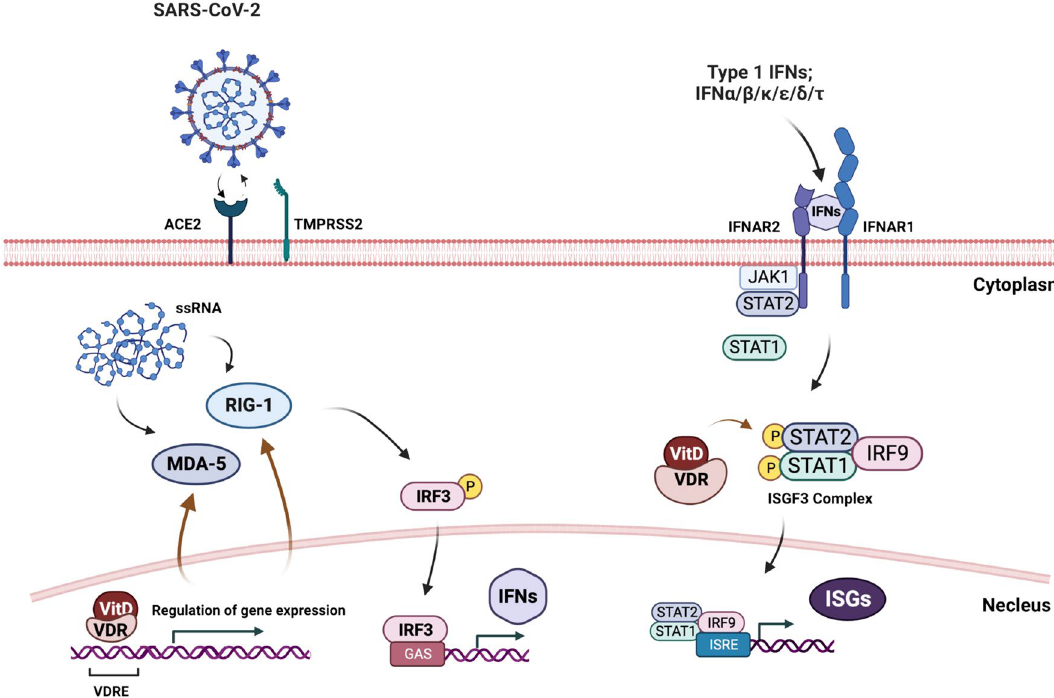
Figure 5. Schematic overview of the study findings. VitD enhances signaling of RIG-1/MDA-5 and JAK-STAT pathways and the resultant production of MX-1 and ISG-15 antiviral